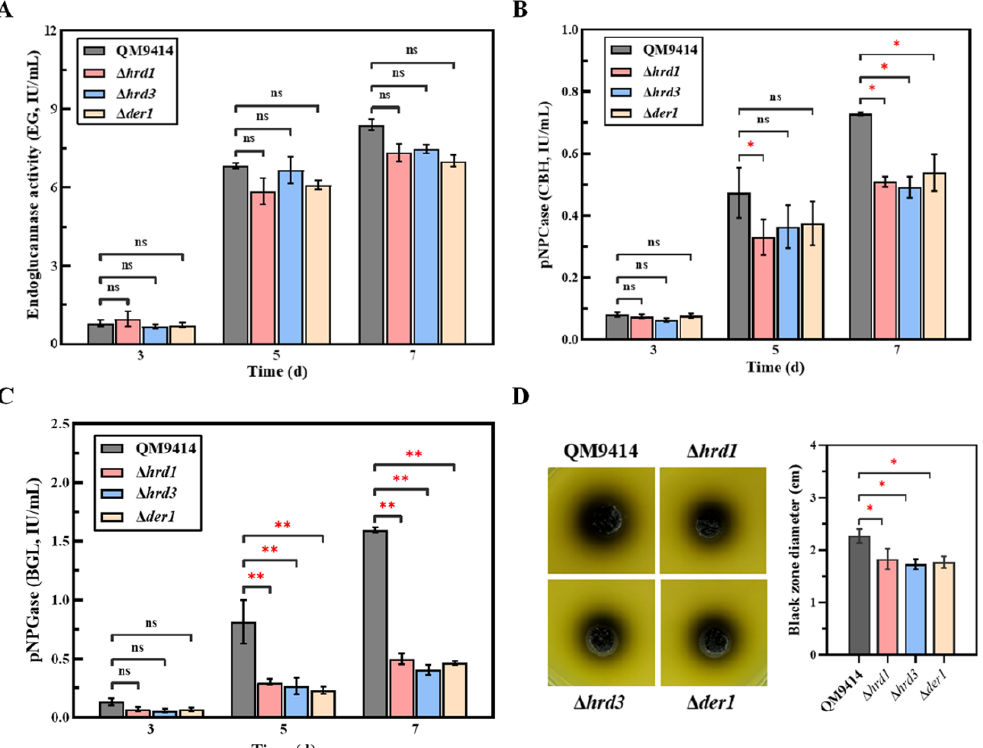
Figure 4. Cellulase secretion of the ERAD-deficient mutants under cellulase induction conditions. The endo- β -1,4-glucanase (EG) activity ( A ), the cellobiohydrolase (CBH) activity ( B ) and the β -glucosidase (BGL) activity ( C ) were detected in fermentation supernatants on the 3rd, 5th and 7th days. The parental strain QM9414 and the ERAD-deficient mutants were cultivated in a cellulase-inducing medium containing 2% microcrystalline cellulose and 2% corn steep liquor at 30 °C. ( D ) Intuitive analysis of the secreted β -glucosidase activity in the CMC-esculin plates experiment. The secretion of β -glucosidase was evaluated by measuring the diameter of the resulting black zone. Values represent the mean of three repeated measurements taken from at least three parallel experiments. The error bars refer to the standard deviations. The difference between the parental strain and the knockout strains was shown by analysis of ANOVA followed by Tukey’s test. * p < 0.05; ** p < 0.01. ns, not significant.